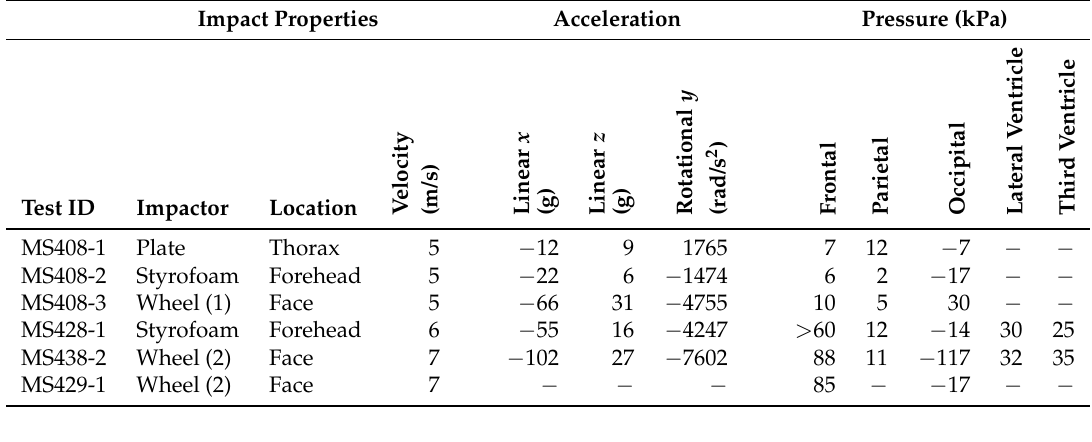
Table 2. Summary of impact conditions and peak values for the skull (whole head) accelerations and intracranial pressure responses across all scenarios tested experimentally by Trosseille et al. [38].